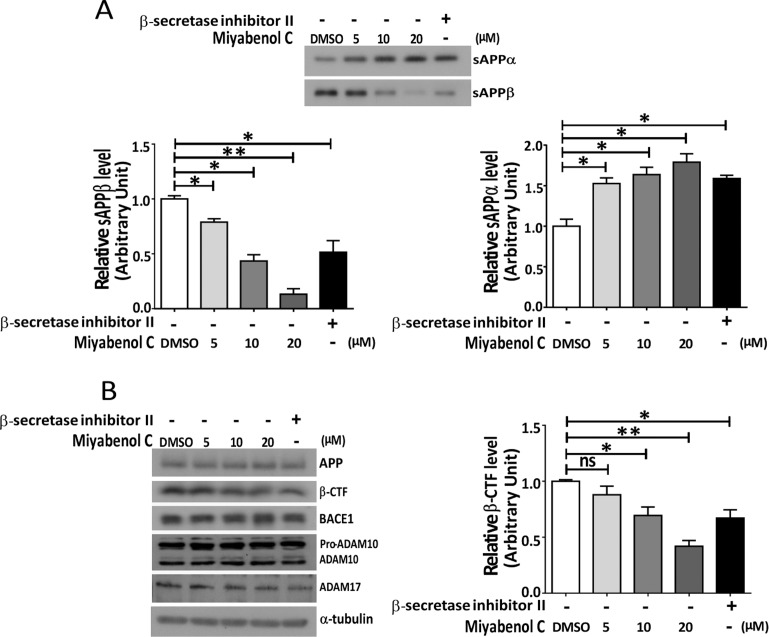
Miyabenol C treatment reduces APP β-CTF and sAPPβ levels and increases sAPPα levels.N2a695 cells were treated with DMSO (negative control), β-secretase inhibitor II (2μM) or indicated doses of miyabenol C for 10h. (A) Conditioned media and (B) cellular lysates were subjected to SDS-PAGE and Western blot. sAPPα, sAPPβ and β-CTF levels were quantified by densitometry using image J for comparison (One-way ANOVA followed by Tukey’s post hoc test, n = 3, ns: p>0.05, *: p<0.05, **: p<0.01).